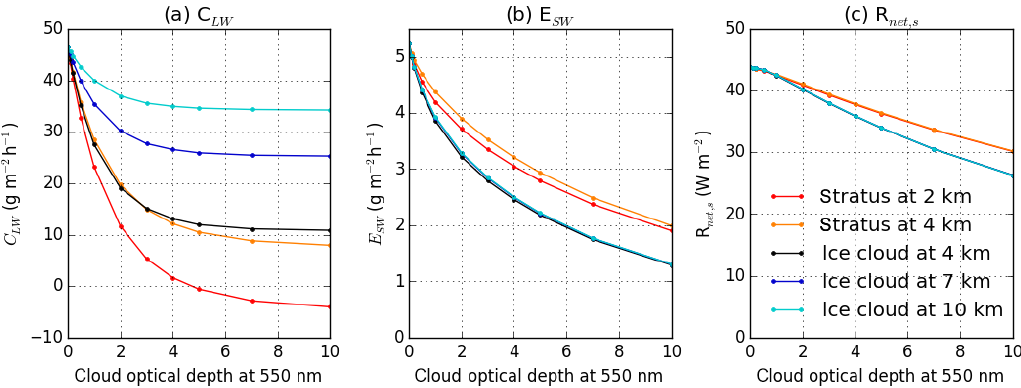
Figure 10. Sensitivity of C LW (a) , E SW (b) and R net , s (c) (defined in Sect. 2.1) to the altitude, type and visible optical depth of a cloud appearing above the fog. All other input data are kept constant at the values for 13 December 2015 at 10 UTC (the same time as in Fig. 9). Solar zenith angle is 75.7 ◦